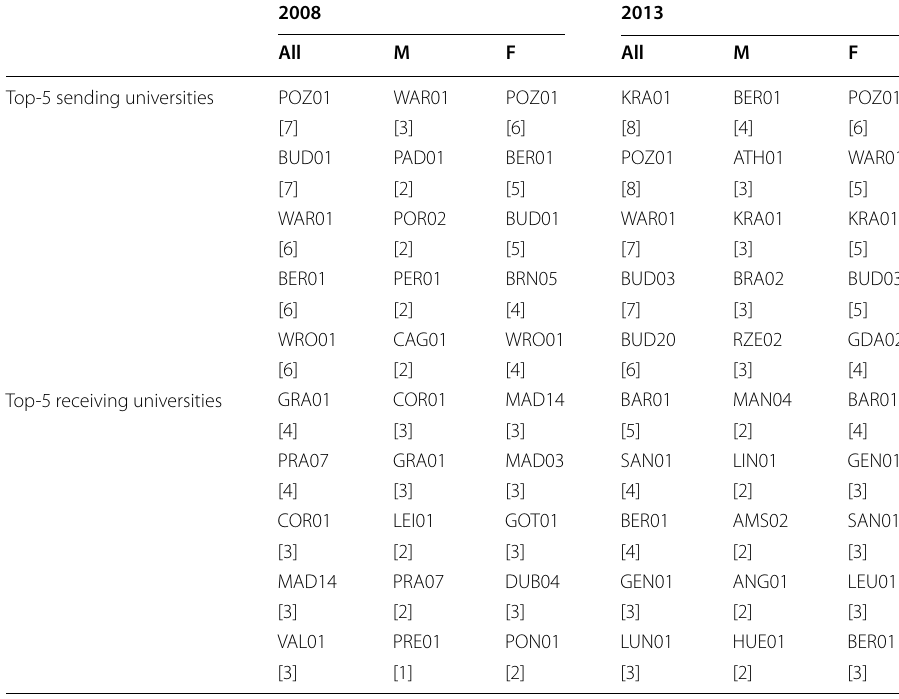
Table 3 Summary statistics—Erasmus network Special needs—2008 and